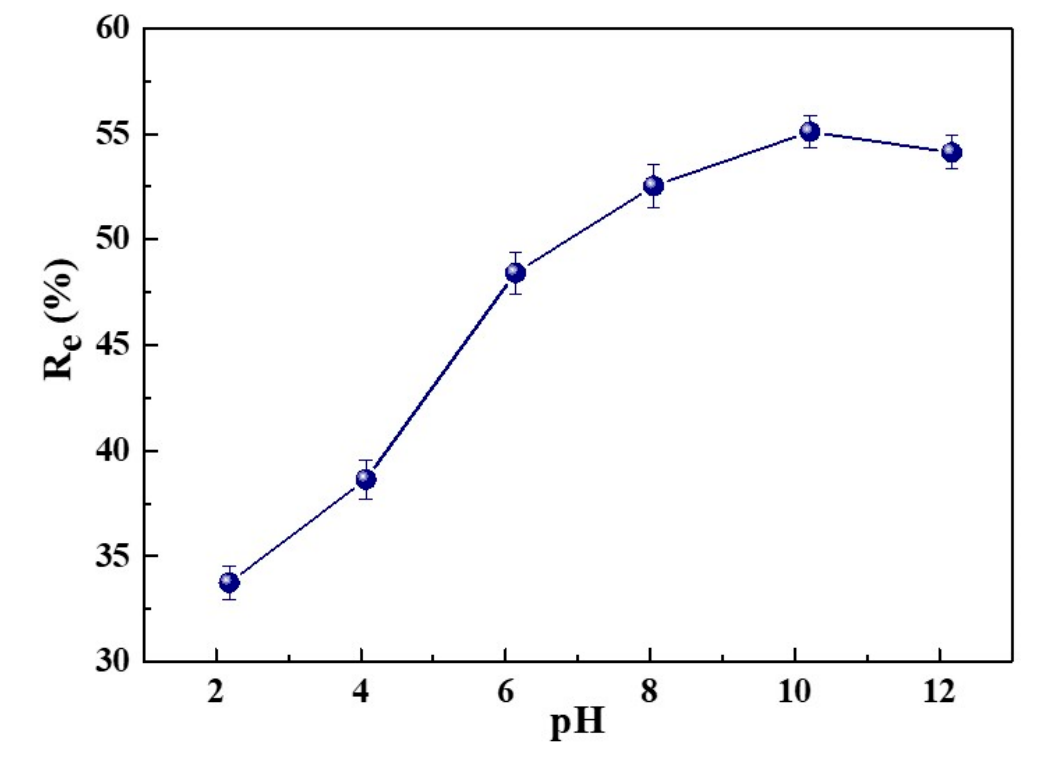
Figure 8. The effect of the solution’s initial pH on R e of MB by SC1050.